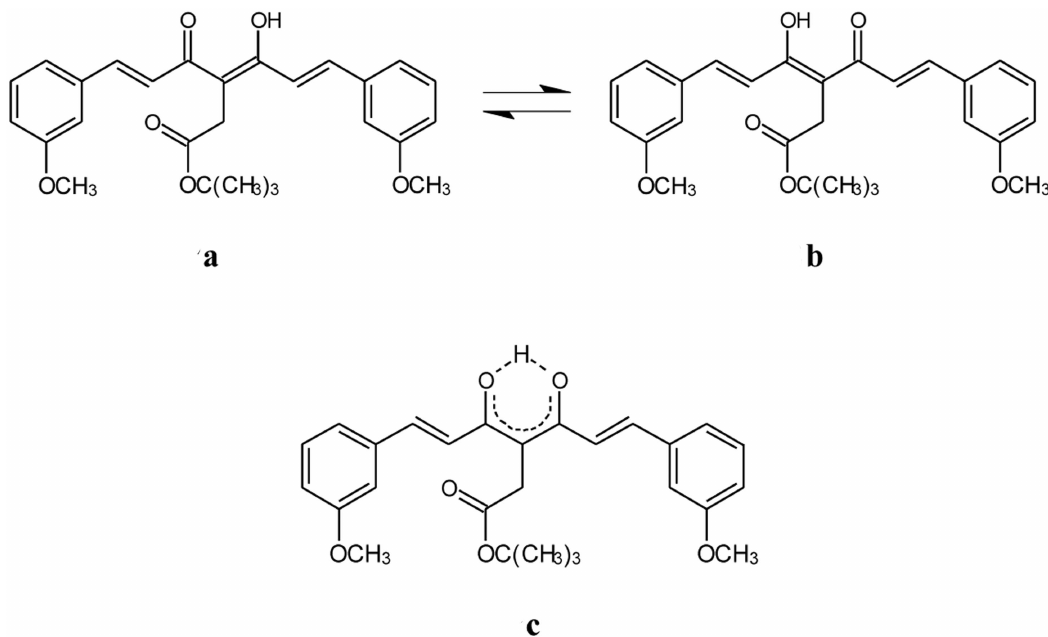
Fig 3. Tautomeric equilibrium between C s and C 2v enol forms of K2T23. The asymmetric C s structures a and b may interconvert through a C 2v -like transition state, or the latter, symmetric structure c, may be more representative of the closed keto-enol conformer of K2T23 in the